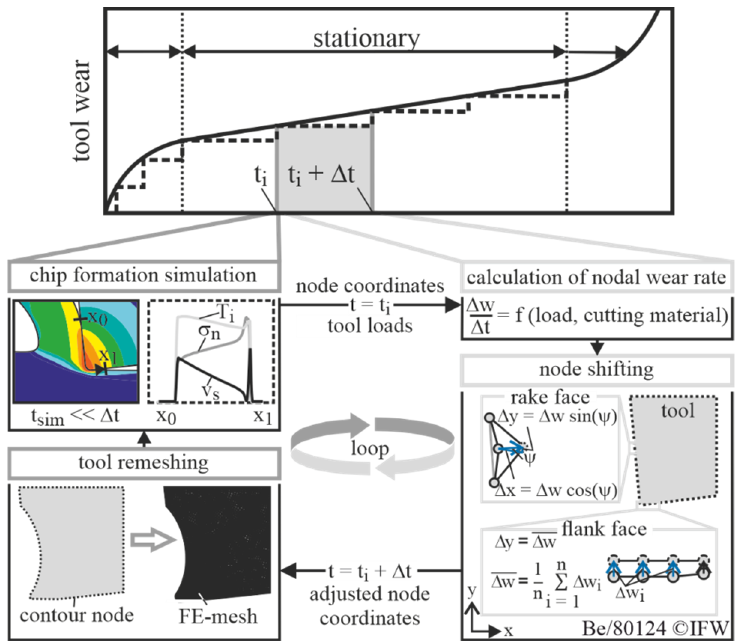
Figure 13. Procedure for simulating the tool life time.